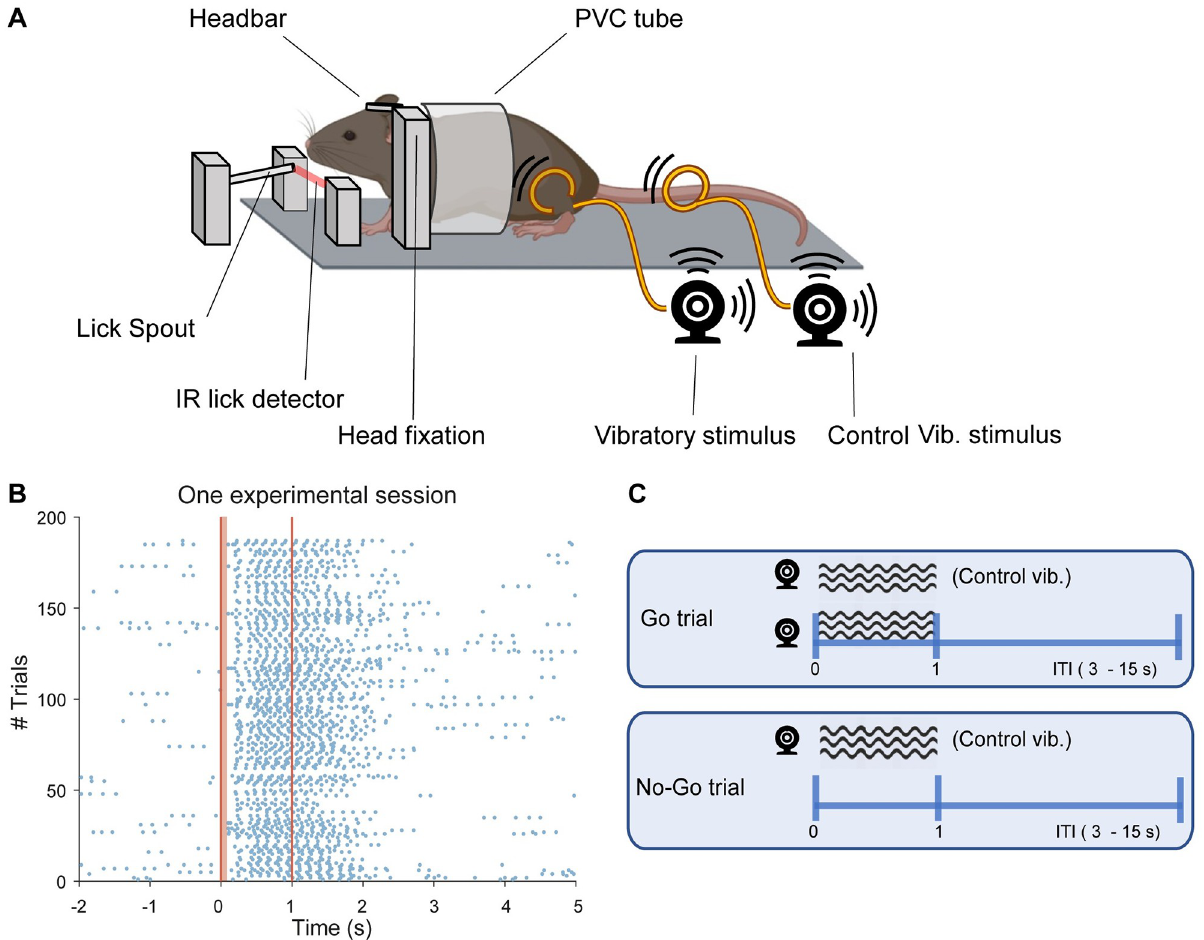
Fig 1. Vibro-tactile behavioural task. (A) Schematic representation of the behavioural set-up. The mouse enters the PVC tube, it is fixed to the head- fixation supports, and its hindlimb is surrounded with a plastic cable (orange) which delivers a vibrotactile stimulus from an attached vibratory motor. A second motor, not attached to a limb, is used to deliver a control vibration during probe trials and verify that mice do not respond to the sound produced by vibratory motors. A lick spout delivers a reward if a lick is detected by an infrared (IR) lick detector following the delivery of tactile stimuli. Reprinted from Biorender under a CC BY license, with permission from Biorender, original copyright 2023. See also S1A Fig for a photo of the setup. (B) Lick response raster plot from one session recorded during the Final Stage. Blue dots correspond to individual licks. The brown bar between 0 and 0.1 s indicates a no reward window. Licks detected in this window are not rewarded, accounting for physiological reactions time. Dark vertical lines at 0 and 1 second indicate the response window. Note that the lick distribution is time-locked to stimulus presentation, indicating that the mouse responded to tactile stimuli. (C) Outline of the Go and No-Go trials (Final Stage). Black circles and waves represent the vibratory motors and their stimuli. Stimulus time goes on from 0 to 1 second and ITI lasts from 3 to 15 seconds, randomly. A reward is only delivered upon licking during Go trials. Panel A was created with BioRender.com. Vib .: vibratory; ITI : intertrial interval .